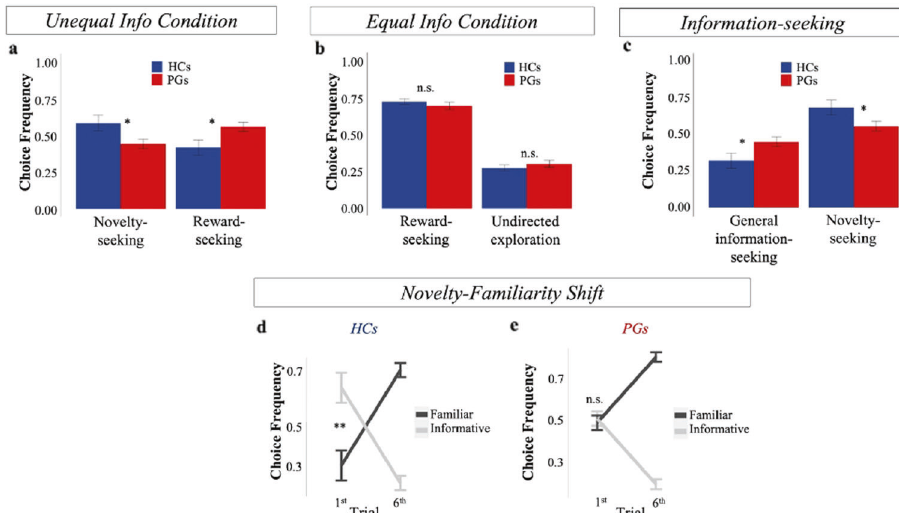
Fig. 2 Model-Free analysis. a Frequency of making novelty-seeking and reward-seeking choices over the total number of novelty-seeking and reward-seeking trials in the fi rst free-choice trial of the Unequal Information condition (i.e., when options are sampled unequally during the forced-choice task; Unequal Info Condition in the fi gure). Novelty-seeking choices decreased and reward-seeking choices increased in PGs compared to HCs. b Frequency of engaging in reward-seeking and undirected exploration in the fi rst free-choice trial of the Equal Information condition (i.e., when options are sampled equally during the forced-choice task; Equal Info Condition in the fi gure). No difference was observed between the two groups. c Frequency of engaging in novelty-seeking and general information-seeking over the total number of information-seeking trials in the fi rst free-choice trial of the Unequal Information condition: PGs have reduced information-seeking toward novel options ( novelty-seeking ) relative to information-seeking toward options selected twice in the forced-choice task ( general information- seeking ). d HCs showed a novelty-familiarity shift: increased preference toward informative options in the fi rst free-choice trial, and increased preference for familiar alternatives in the last free-choice trial. e PGs showed no preference between informative and familiar options in the fi rst free-choice trial, but a signi fi cant preference toward familiar options on the last free-choice. In all the fi gures, error bars represent the standard error of the mean ( β vs. k , ν ), and of novelty and knowledge on information-seeking ( ν vs. k ). The model ’ s parameters are estimated by fi tting nkRL to trial-by-trial participants ’ free choices (Supplementary methods).